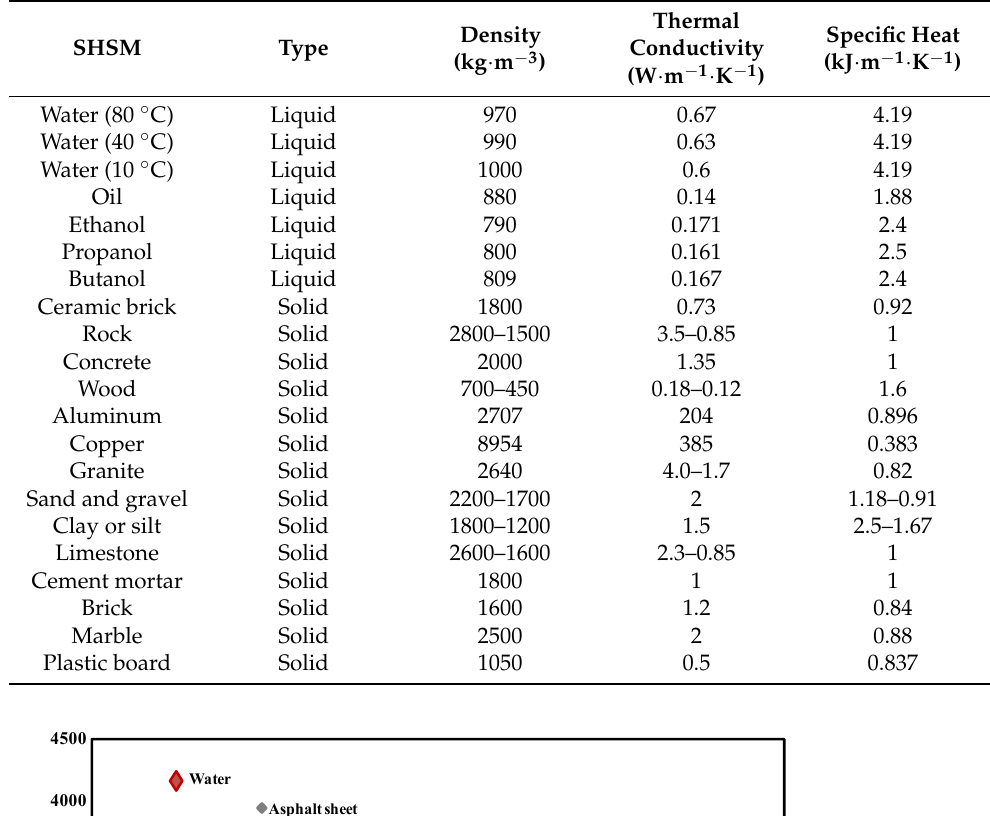
Table 4. Thermophysical properties of some commonly used SHSMs [3,18,19,41], reprinted/adapted with permission from Refs. [18,19], 2022, Elsevier.